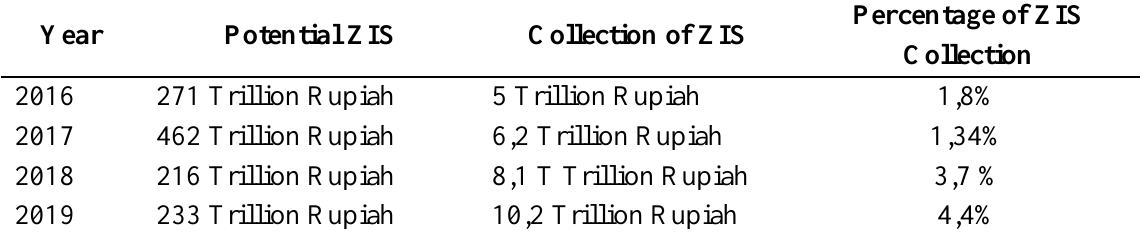
Table 1 : Potential and Collection of ZIS